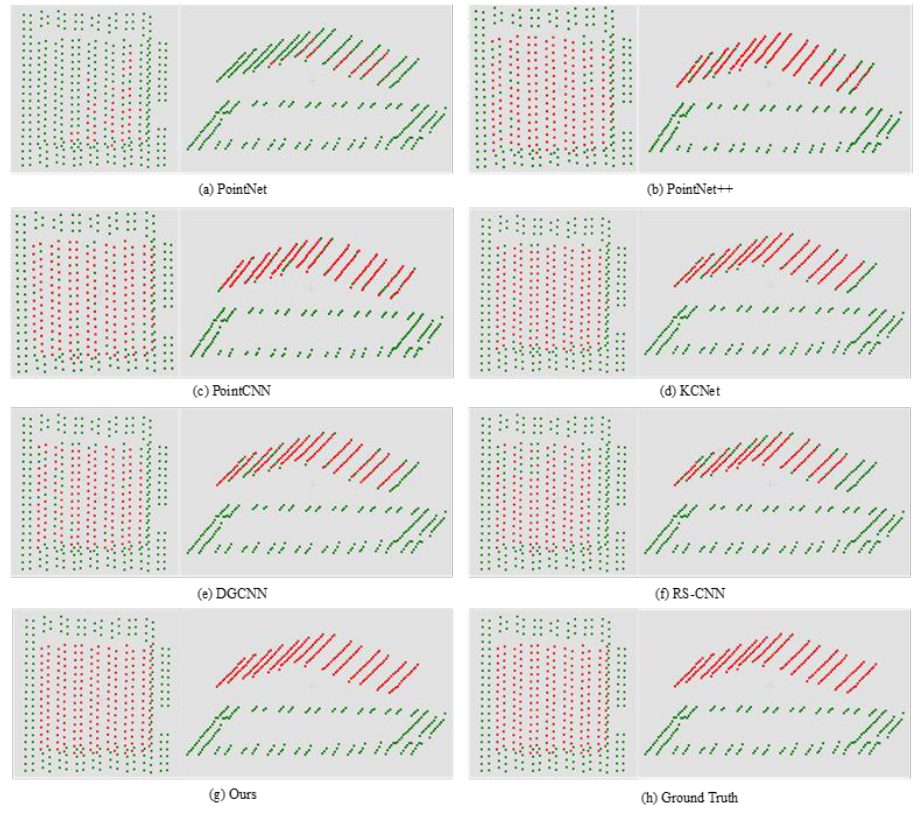
Figure 10. The details visualization of easy level comparison results. For each model, the left image is the vertical view, and the right image is the side view.